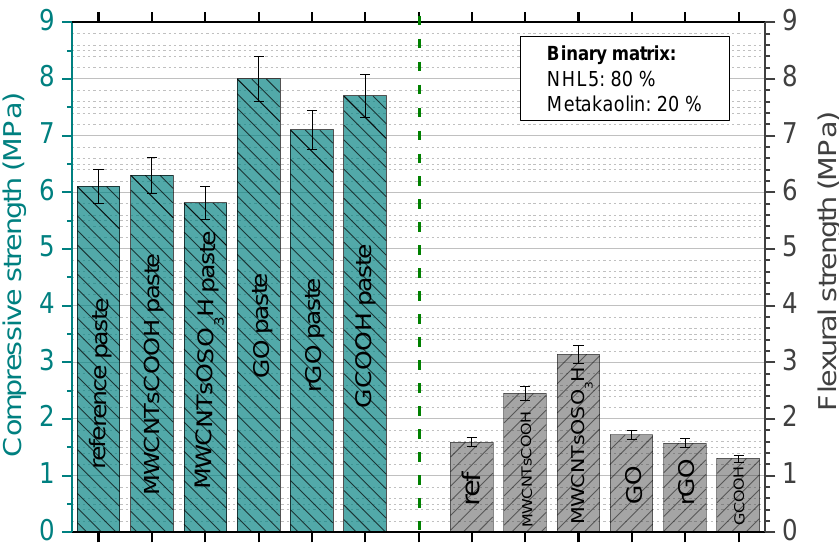
Figure 9. Mechanical test results of compressive and flexural strengths of the NHL/MK pastes reinforced with different type of carbon nanostructures (concentrations can be found in Table 2).